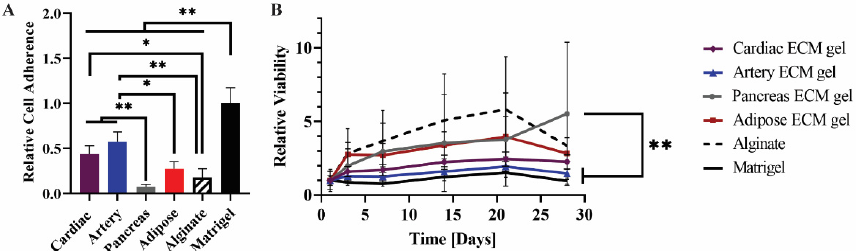
Figure 6. hiPSCs culture on the pECM hydrogels. ( A ) Cell adherence on the pECM hydrogels, and ( B ) viability along 28 days of spontaneous differentiation on different pECM hydrogels relative to the viability on each material at day 1 (control). n = 5, * p < 0.01, ** p < 0.001. Int. J. Mol. Sci. 2021 , 22 , x FOR PEER REVIEW